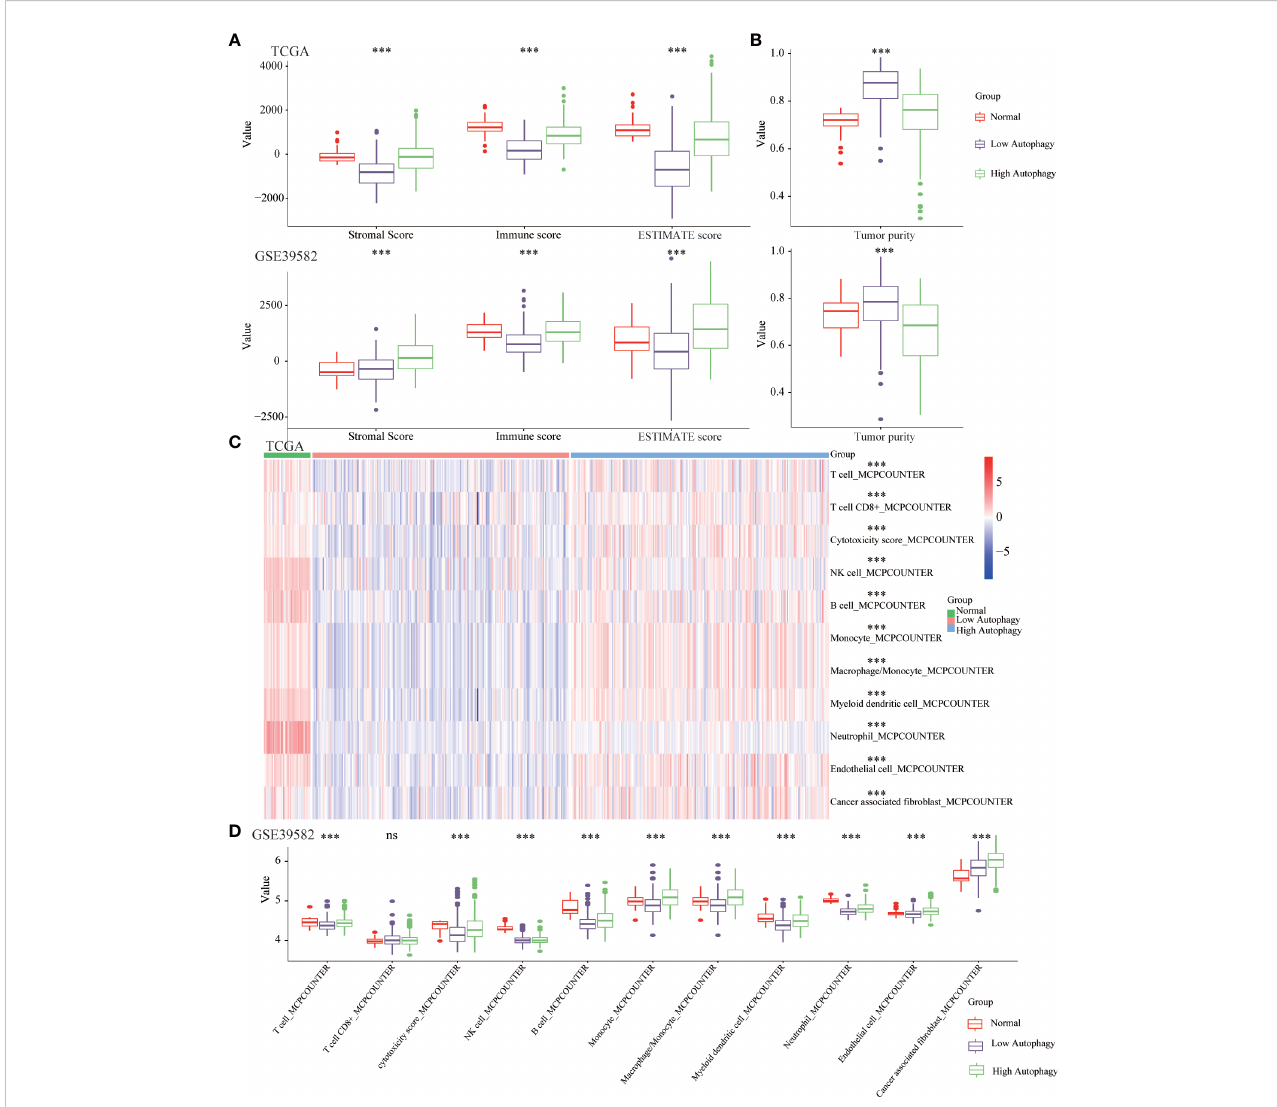
FIGURE 2 The COAD tissues of the high autophagy group were more like “ hot ” tumors. Comparison of the stromal score, immune score, ESTIMATE score (A) , tumor purity (B) , abundance of 11 kinds of tumor-in fi ltrating immune cells (TIICs) (C, D) between normal, low and high autophagy score group. (*** P - value <0.001; ns, P-value >